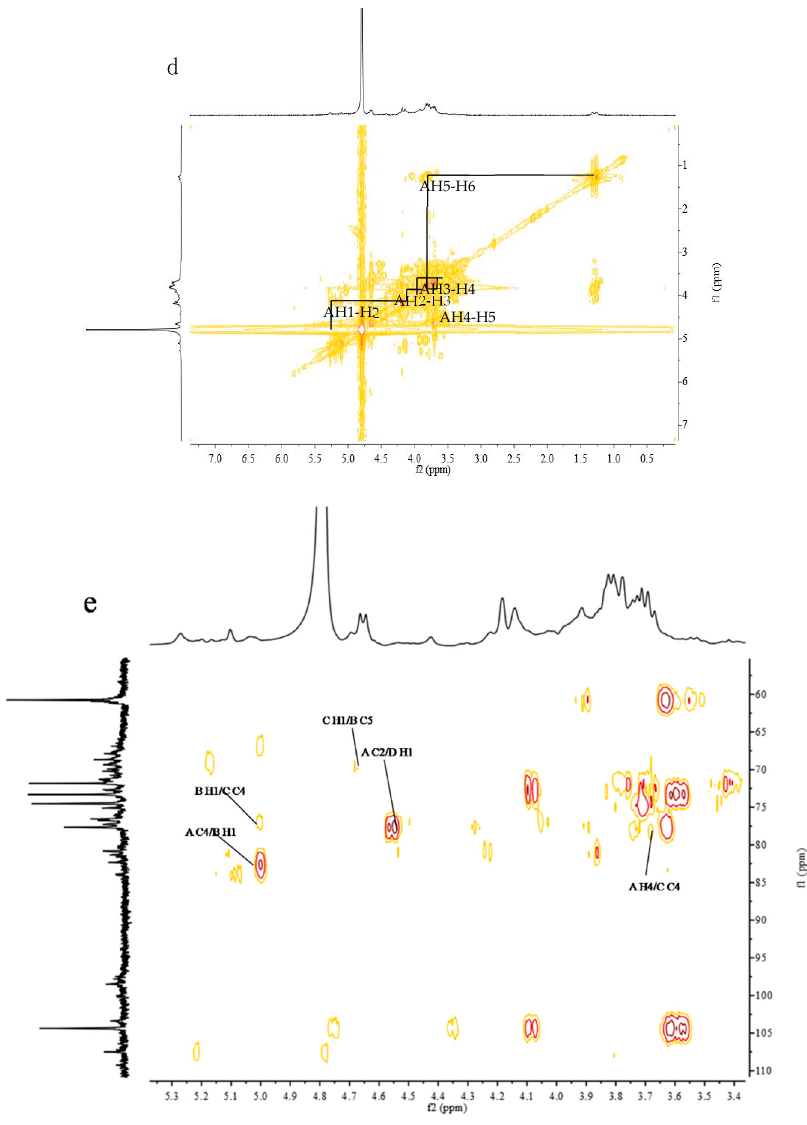
Figure 5. ( a ) 1 H-NMR spectrum (400 MHz, D 2 O, 30 °C); ( b ) 13 C NMR spectrum (100 MHz,.D 2 O, 30 °C); ( c ) 1 H/ 13 C HSQC correlation spectrum; ( d ) 1 H/ 1 H COSY correlation spectrum of PCp-1; and, ( e ) 1 H/ 13 C HMBC correlation